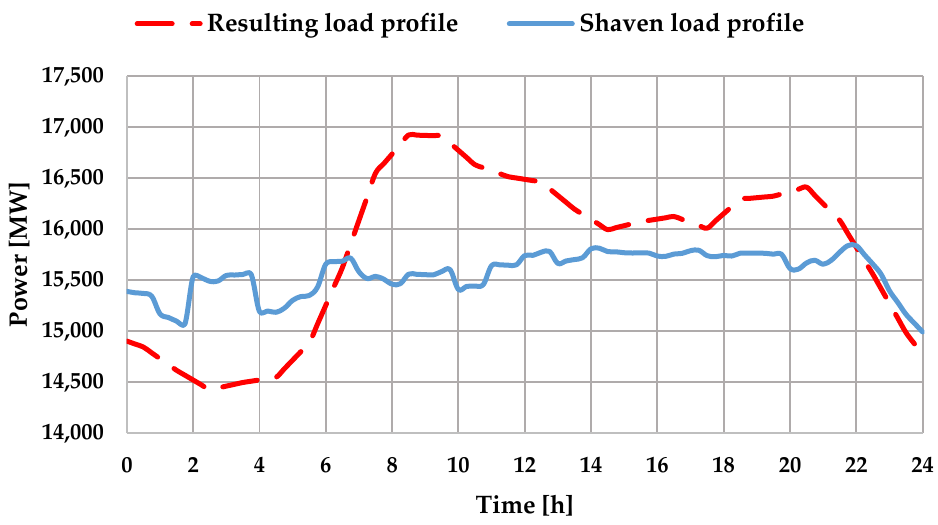
Figure 6. Benefits to the daily load profile after employing the proposed operation algorithm.